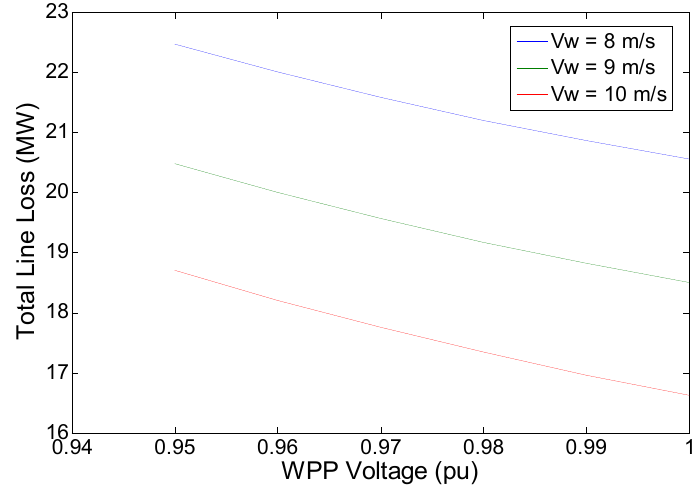
Figure 16. Variation of G1+G2 reactive power.